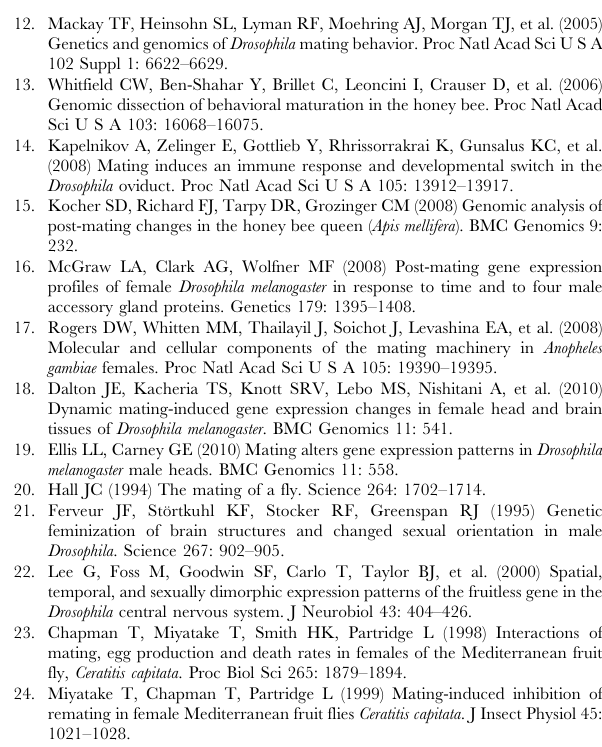
Table S1 Primers used for qRT-PCR analyses. Table S2 Transcripts that change in abundance in mature virgin females compared to immature virgin females. Table S3 Significantly enriched biological process gene ontology annotations among transcripts that showed changes in abundance in mature virgin female heads compared to immature female heads.